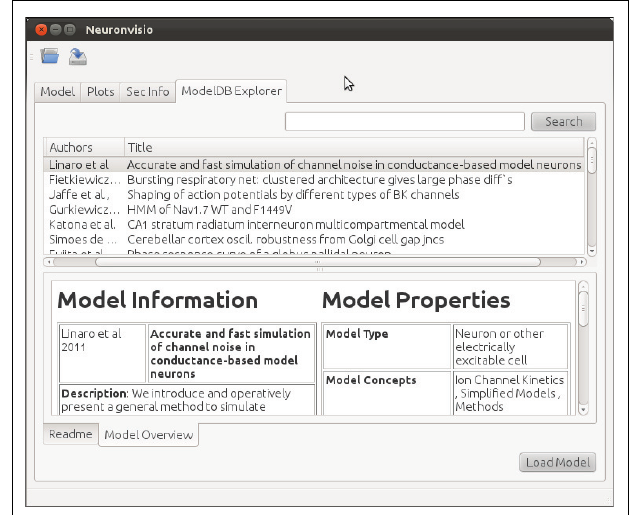
FIGURE 2 | ModelDB Explorer tab. The ModelDB Explorer tab retrieves the list of NEURON models available in ModelDB.The two tabs in the lower panel provide a “Model Overview” and “README” information. Models can be selected in this panel.The Load Model button downloads, extracts, and compiles the selected model, loading it into the current